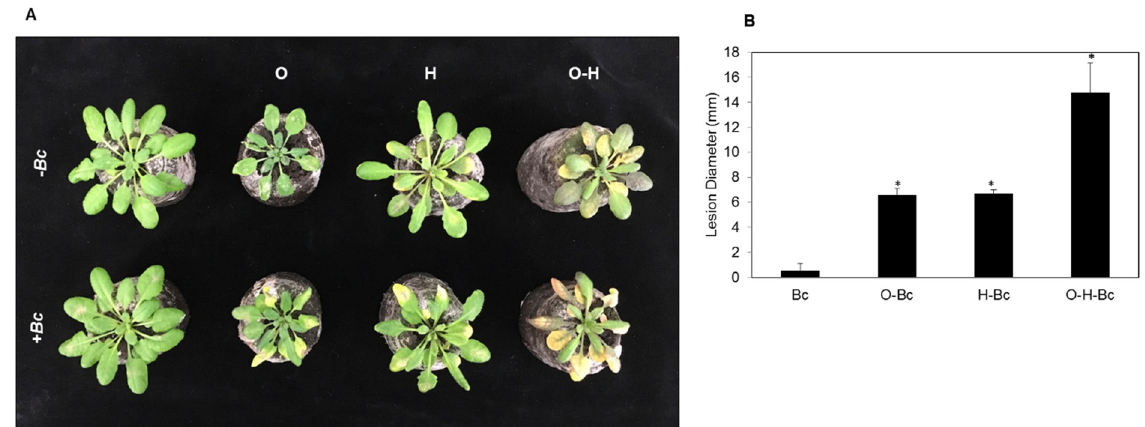
Figure 2. Effect of individual and combined osmotic and heat stresses on plant susceptibility to Botrytis cinerea ( Bc ). ( A ) Phenotype of stressed Arabidopsis (Col-0) plants. Plants were infected with Bc 16 h after the abiotic stress treatments. Photos were taken 3 d after Bc -inoculation. ( B ) Infection degree as lesion size on leaves, measured 3 dpi (days post-infection). O: osmotic stress, H: heat. Bars represent the mean and standard deviation of three biological replicates. Asterisks indicate significant differences, 1-way ANOVA; post-hoc LSD, * p < 0.05. Table 1. List of 20 highly repressed defense-related genes taking into account the individual or the combined osmotic and heat